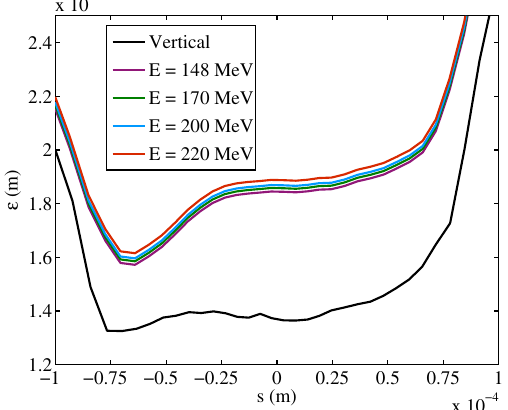
FIG. 12. Simulated horizontal slice emittance along the bunch for different energies ( E ) of the incoming beam. The compression factor is fixed to 15.